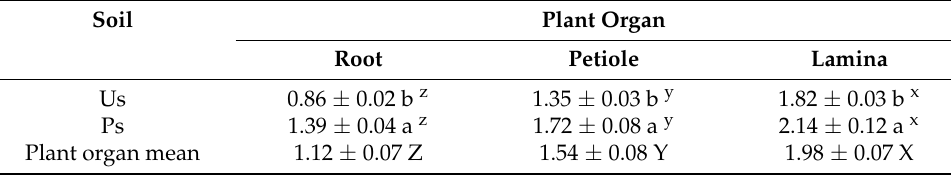
Table 11. Free proline content in different organs of S. perfoliatum plants grown in Ps and Us. Soil Plant Organ Root Petiole Lamina Us Plant organ mean